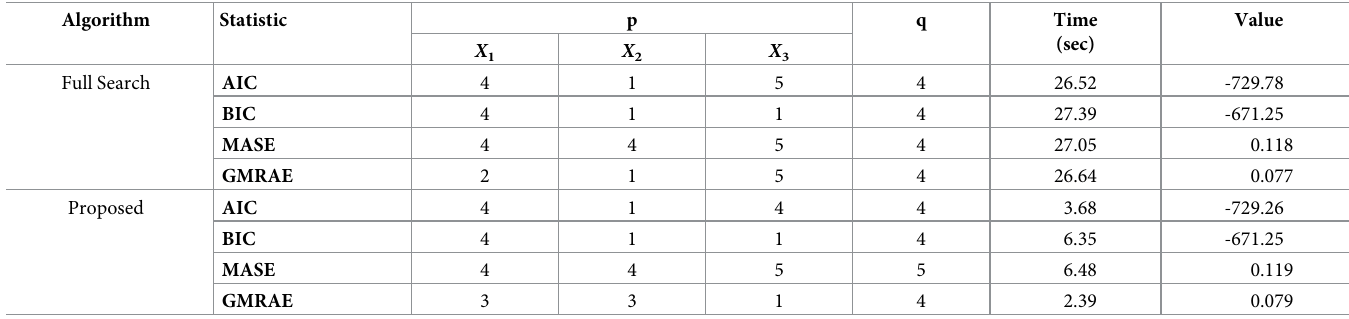
Table 3. Benchmarking of p and q lag orders, implementation time, and the value of GOF statistic for the full-search and the proposed algorithm for Trial 3.